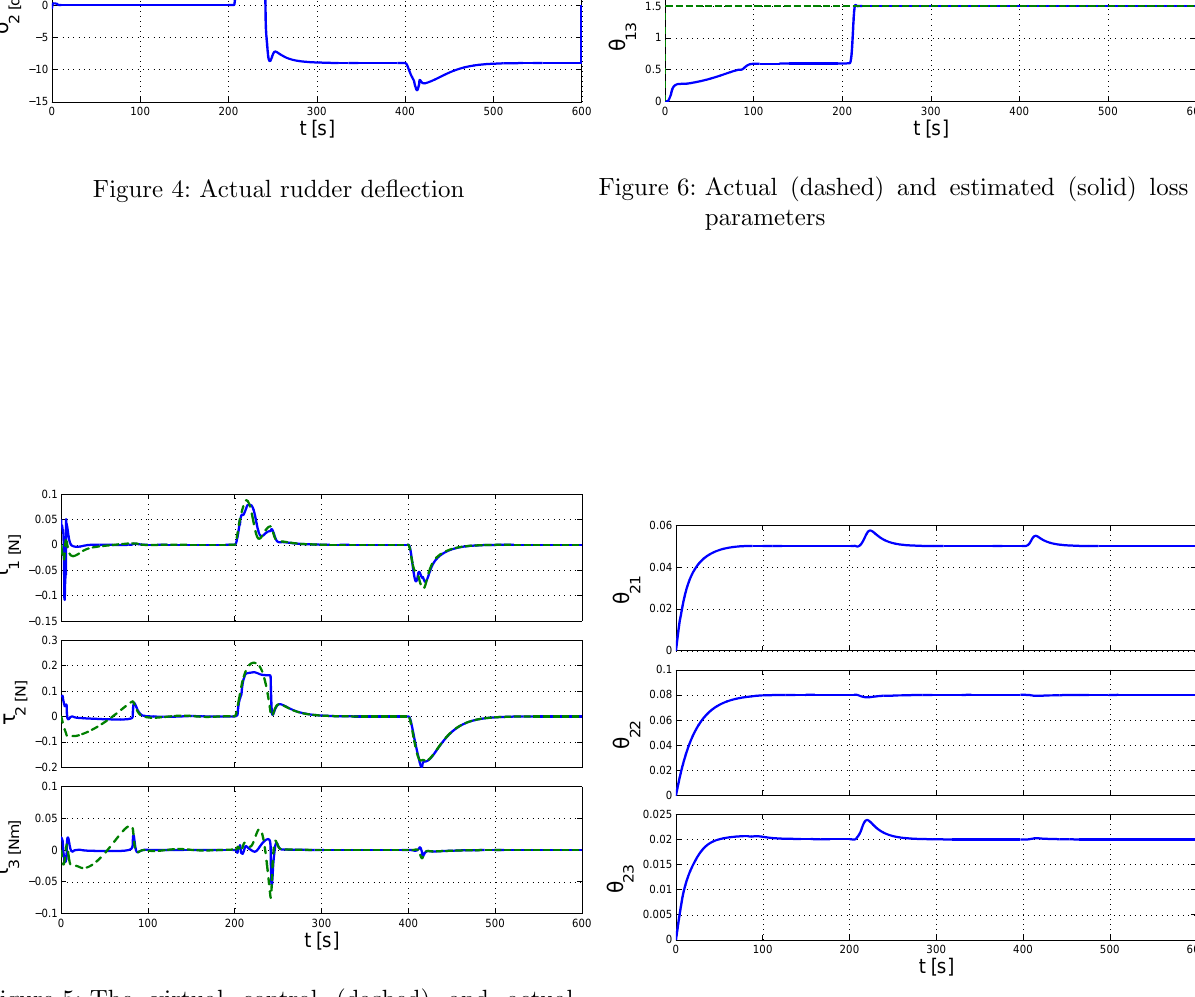
Figure 4: Actual rudder deflection